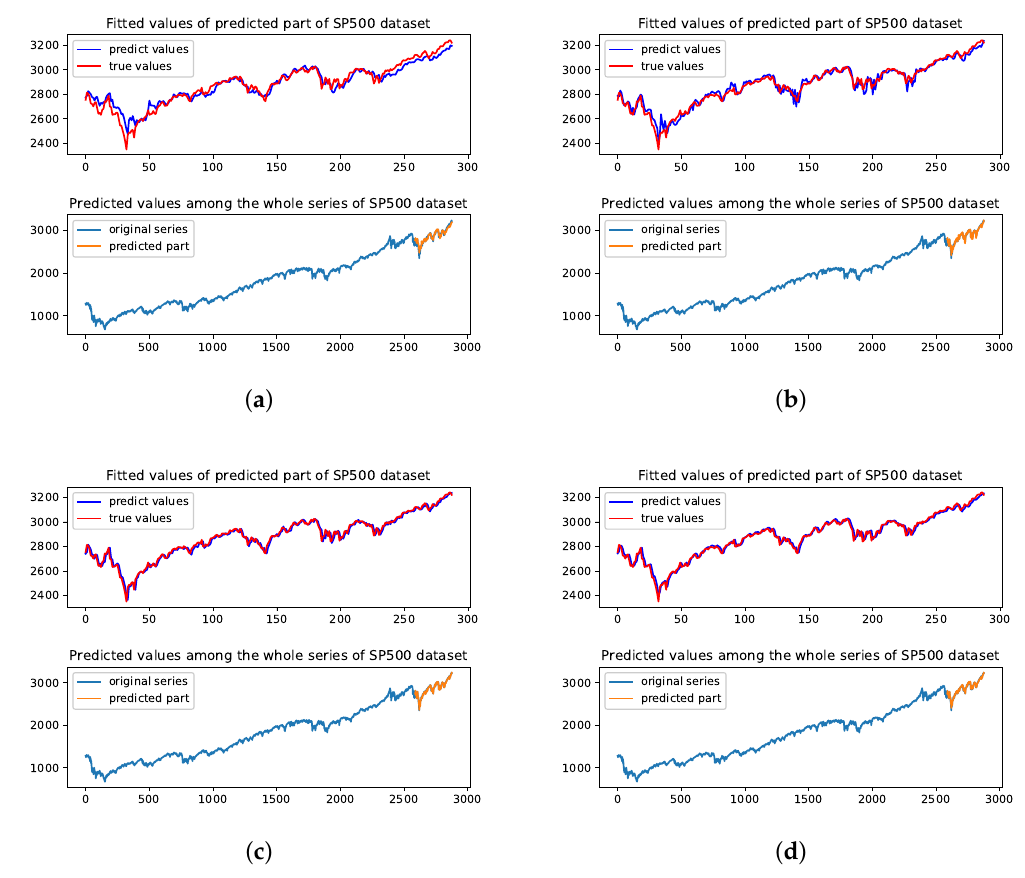
Figure 8. The visualization of the prediction results of the test part and among the whole series on the SP500 dataset with four methods. ( a ) Predicted results of MLP model; ( b ) Predicted results of LSTM model; ( c ) Predicted results of CNN model; ( d ) Predicted results of UA